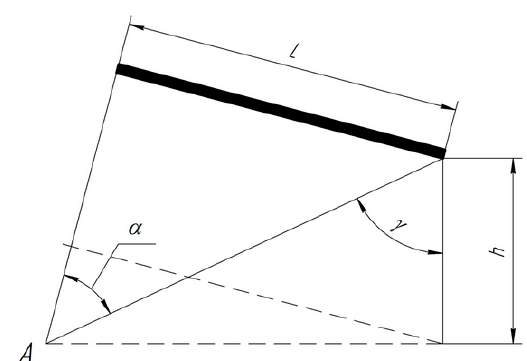
Figure 1. Location of illuminated point under LED lamp.